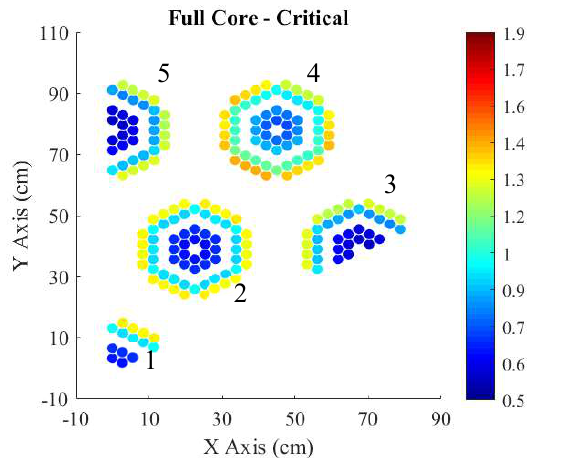
Figure 6. Relative Pin Fission Density Distribution in Critical Full Core Configuration